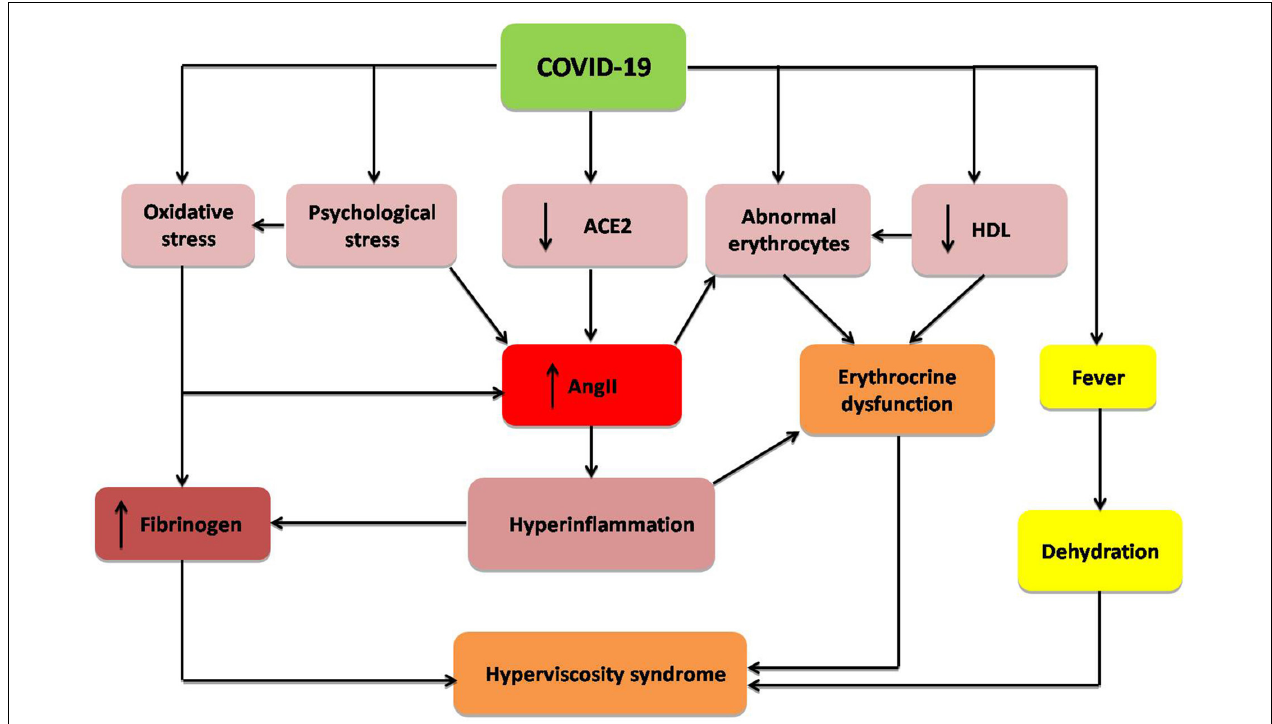
FIGURE 1 | Mechanism of hyperviscosity syndrome in COVID-19: COVID-19 through down-regulation of angiotensin converting enzyme 2 (ACE2), psychological stress, hyperinflammation, oxidative stress, abnormal morphology of erythrocytes, and reduction of high density lipoprotein (HDL). These changes increase fibrinogen level and angiotensin II (AngII), with induction of erythrocrine dysfunction and subsequent development of hyperviscosity syndrome.